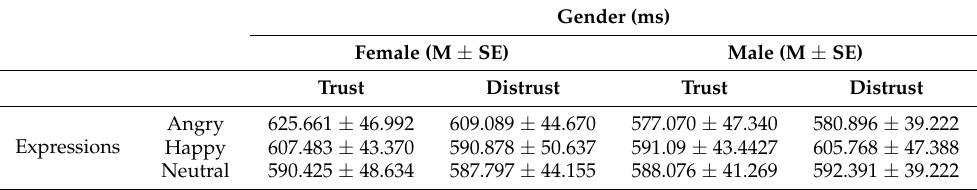
Table 2. Mean reaction time (RT) of different